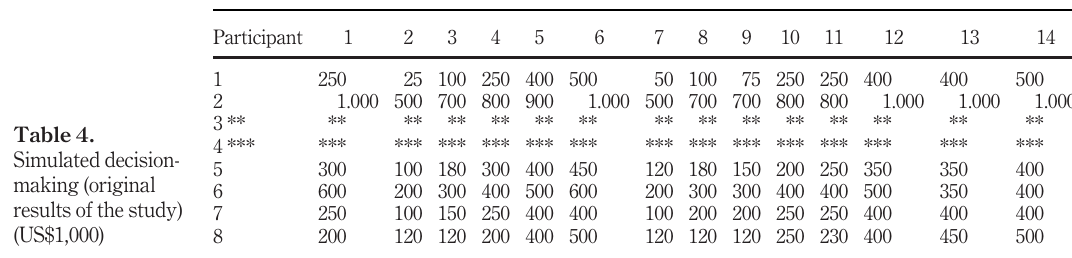
Table 3. Comparison between the number of years making decisions on innovative projects and persistent errors